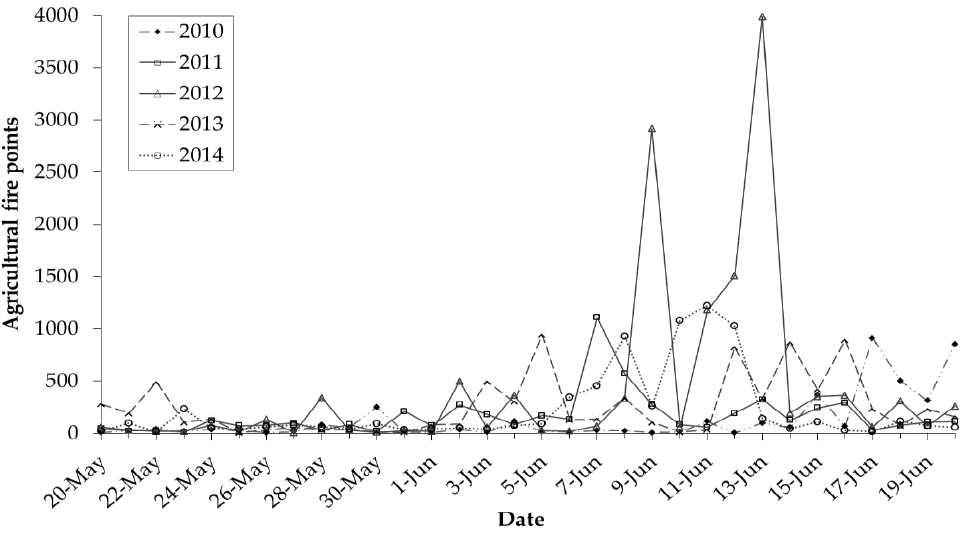
Figure 5. Daily variation in agricultural fires from 20 May to 20 June in China from 2010 to 2014.